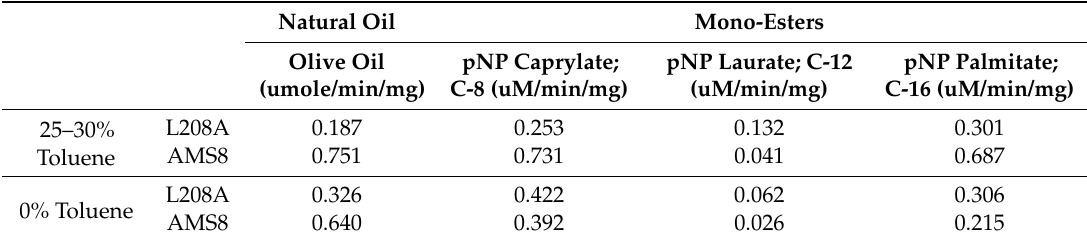
Table 3. Mutant L208A substrate preference.